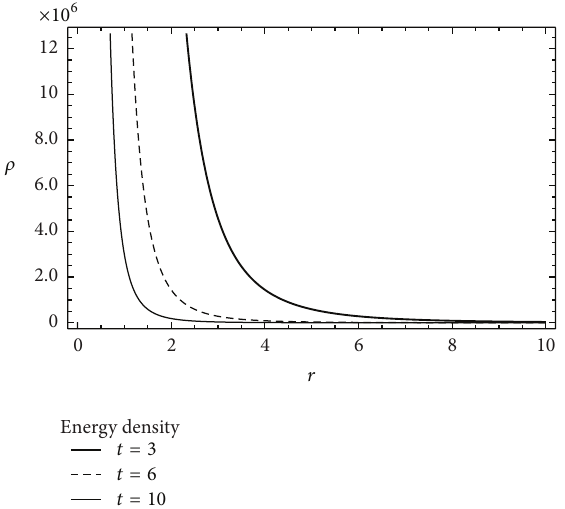
Figure 3: The radial profile for the energy density 𝜌 at various units of time.